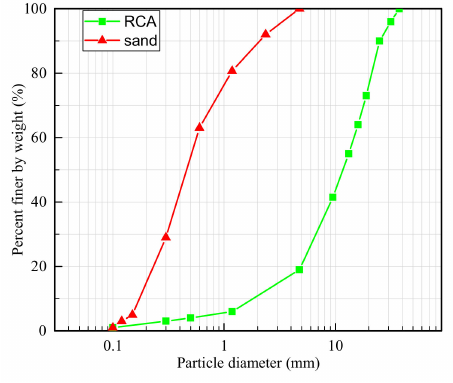
Figure 1. Particle size distributions of sand and RCA.